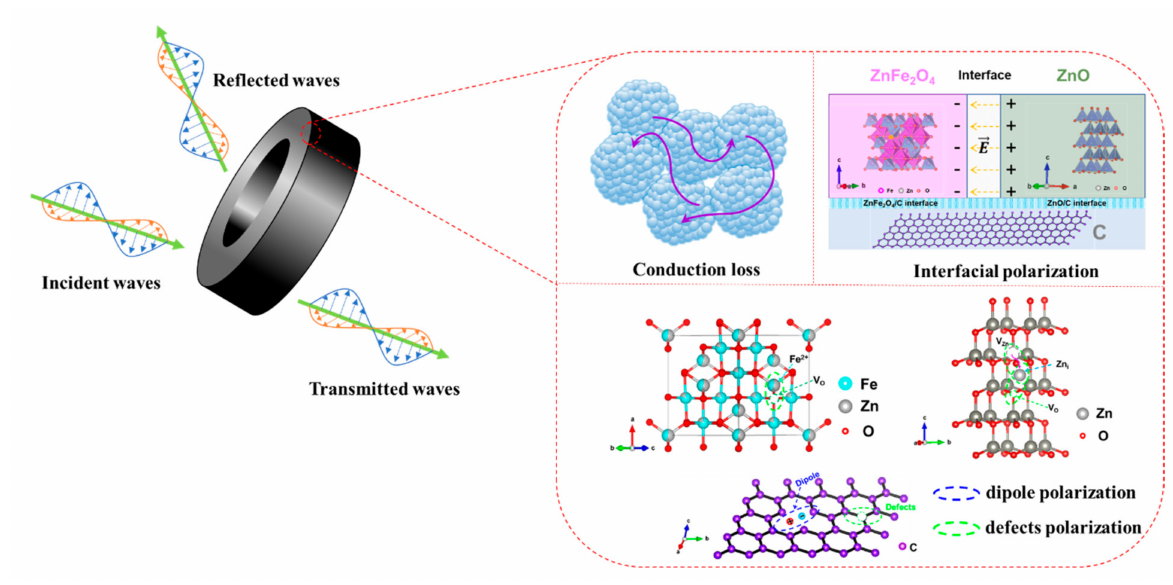
Figure 9. Schematic diagram of the microwave absorption mechanism in ZnFe 2 O 4 /ZnO/C